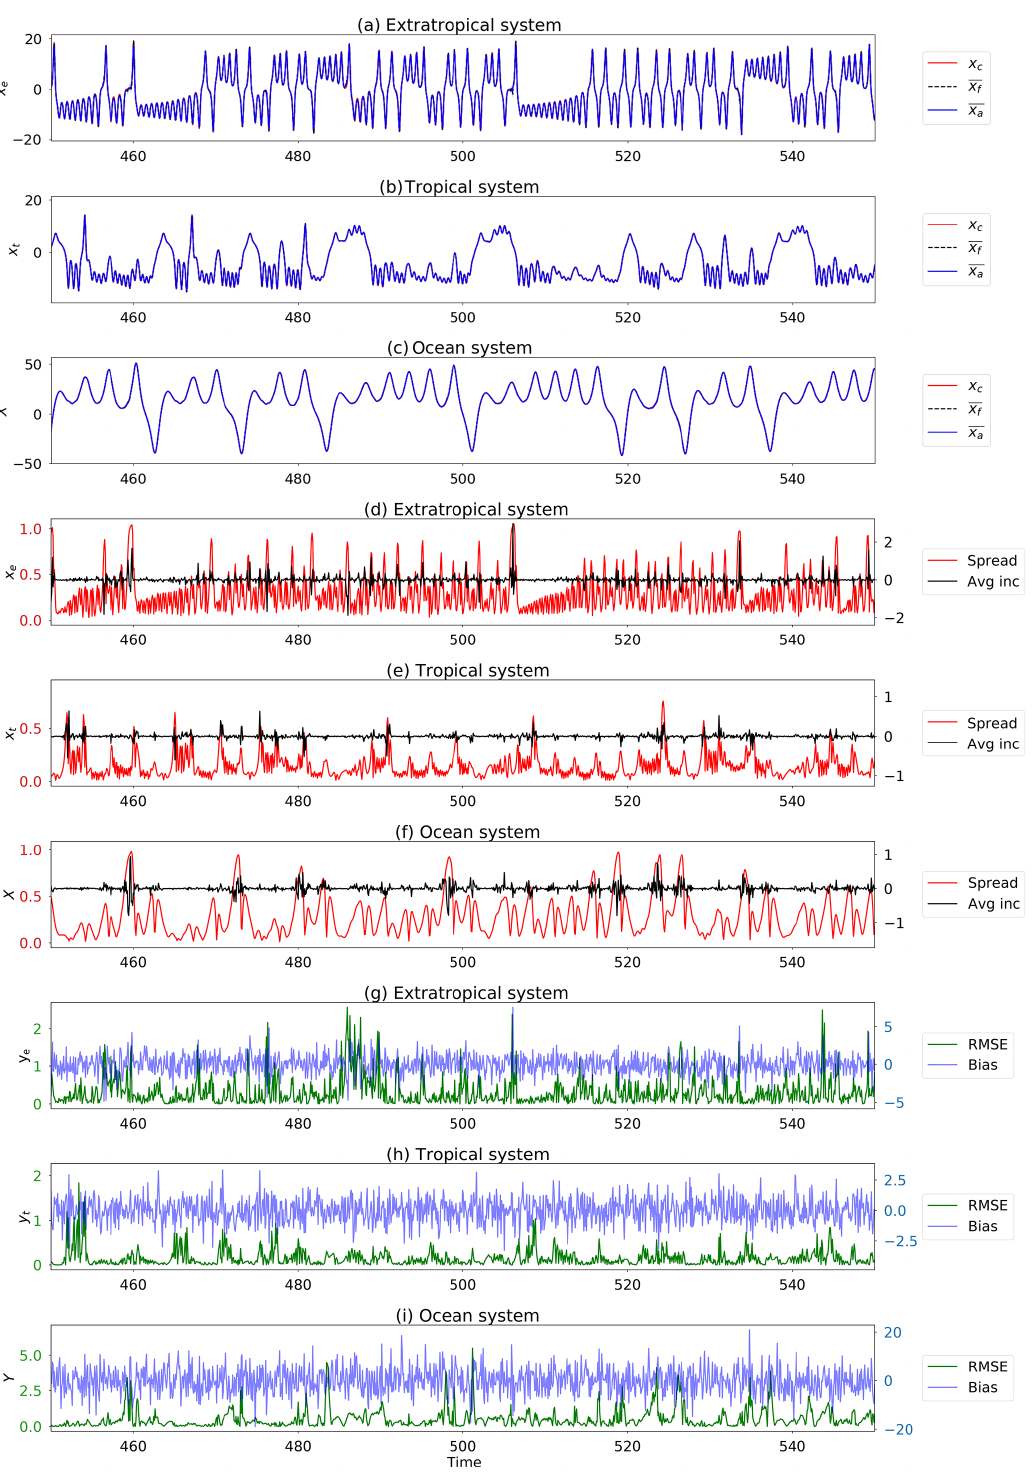
Figure 8. Segment of DA using the variable CLV method and benchmark observations ( y e ,y t ,Y ). (a–c) Trajectories shown are control run (red), ensemble mean (blue), and individual ensemble members (faint). (d–f) Metrics shown are the size of the ensemble spread (red) and ensemble mean increment (black). (g–i) Metrics shown are root mean square error (RMSE, green) and bias (blue). For conciseness we only show the results for one coordinate of each subsystem. The other two coordinates behave similarly. Parameters: assimilation window 0.08, inflation factor 1%, 10 ensemble members, and observation error covariance matrix R = diag ( [ 1 , 1 , 25 ] )